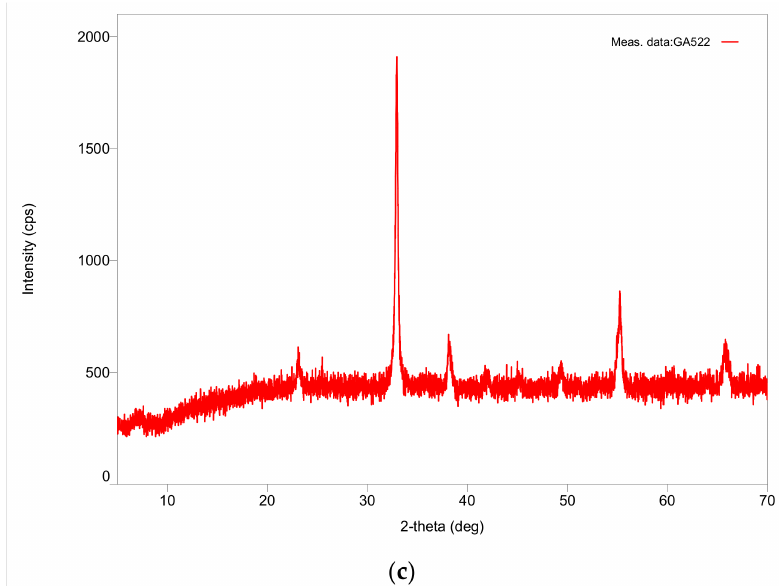
Figure 4. XRD patterns of Co / Si and Mn / Si catalysts showing the location of the reflection planes following the decomposition of the catalyst precursor when microwave power was P = 900 W.